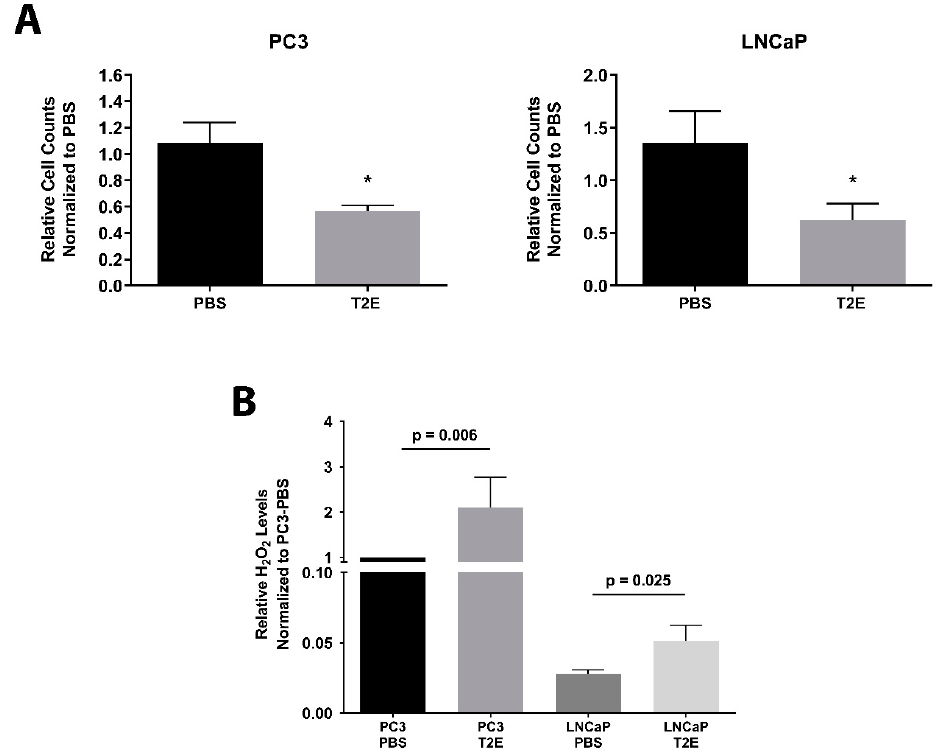
Figure 1. Cell growth and H 2 O 2 levels in PC3 and LNCaP cells treated with PBS or MnTE-2-PyP treatment. ( A ) Both PC3 and LNCaP cells were treated with PBS or 30 µM MnTE-2-PyP (T2E), and cell numbers were calculated 96 h after treatment. ( B ) Intracellular H 2 O 2 levels were measured by